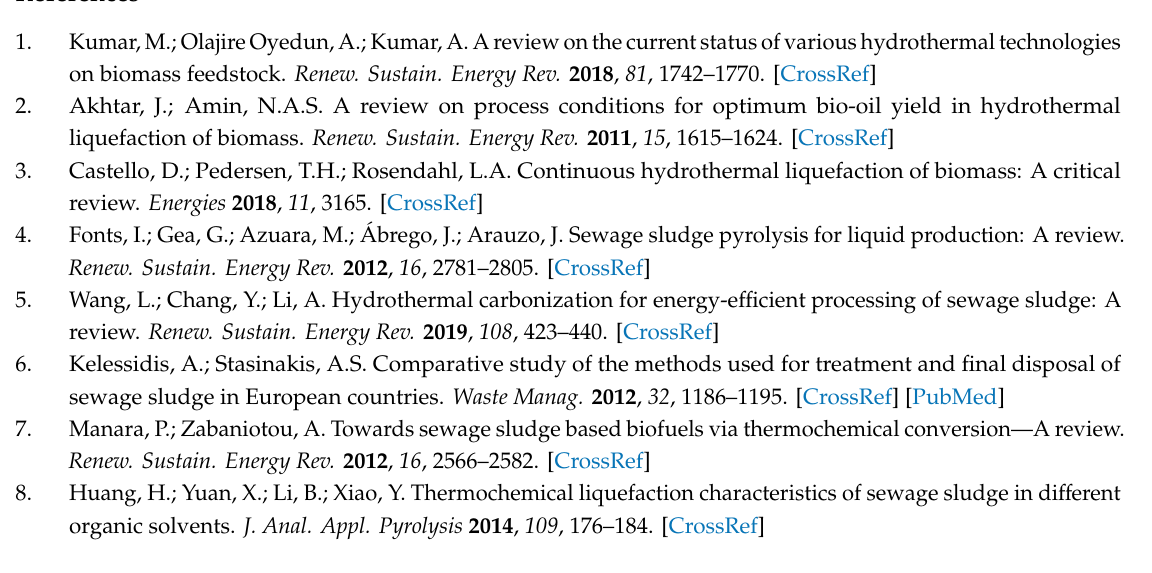
Figure S1. Thermogravimetric curves of SS (a) Volatility curves (b) DTG curves. Figure S2. Calibration curve and concentration of acetic acid in the aqueous phase at di ff erent recycles. Figure S3. Chromatogram of aqueous phase produced from second recycle